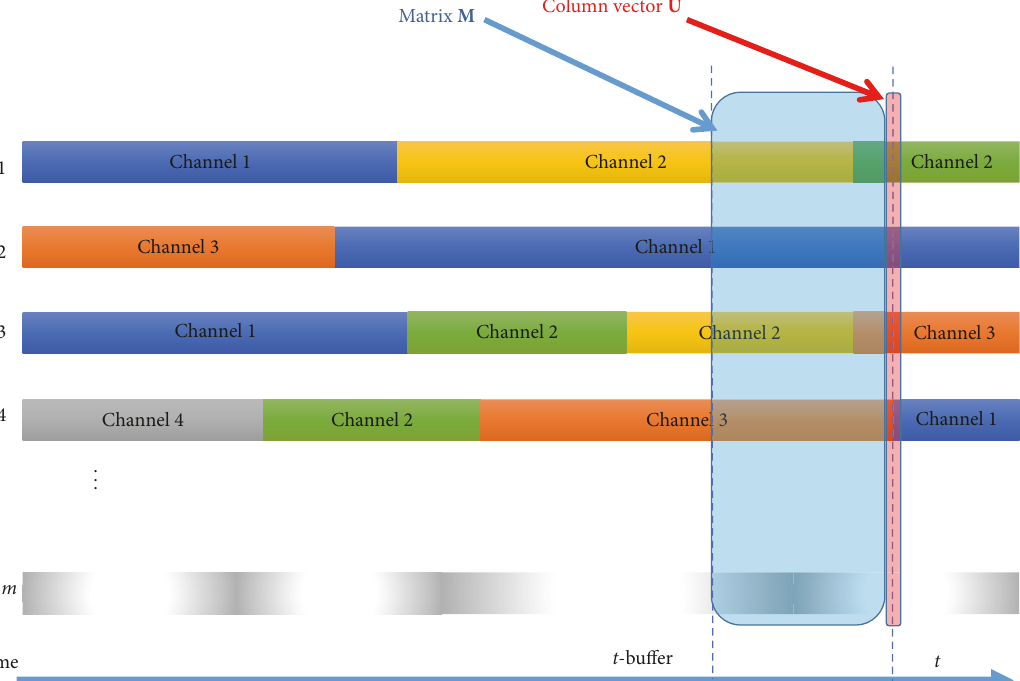
Figure 10: FCCC channel change